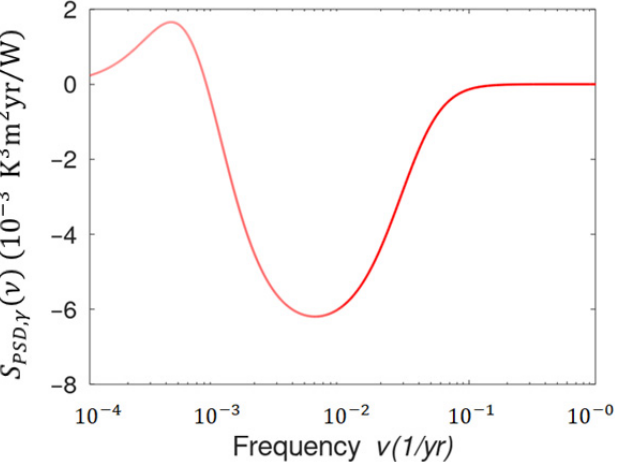
Figure 11. Sensitivity function of power spectral density of the global mean surface temperature fluctuations with respect to the deep ocean heat uptake, determined by the heat exchange coefficient 𝛾 .